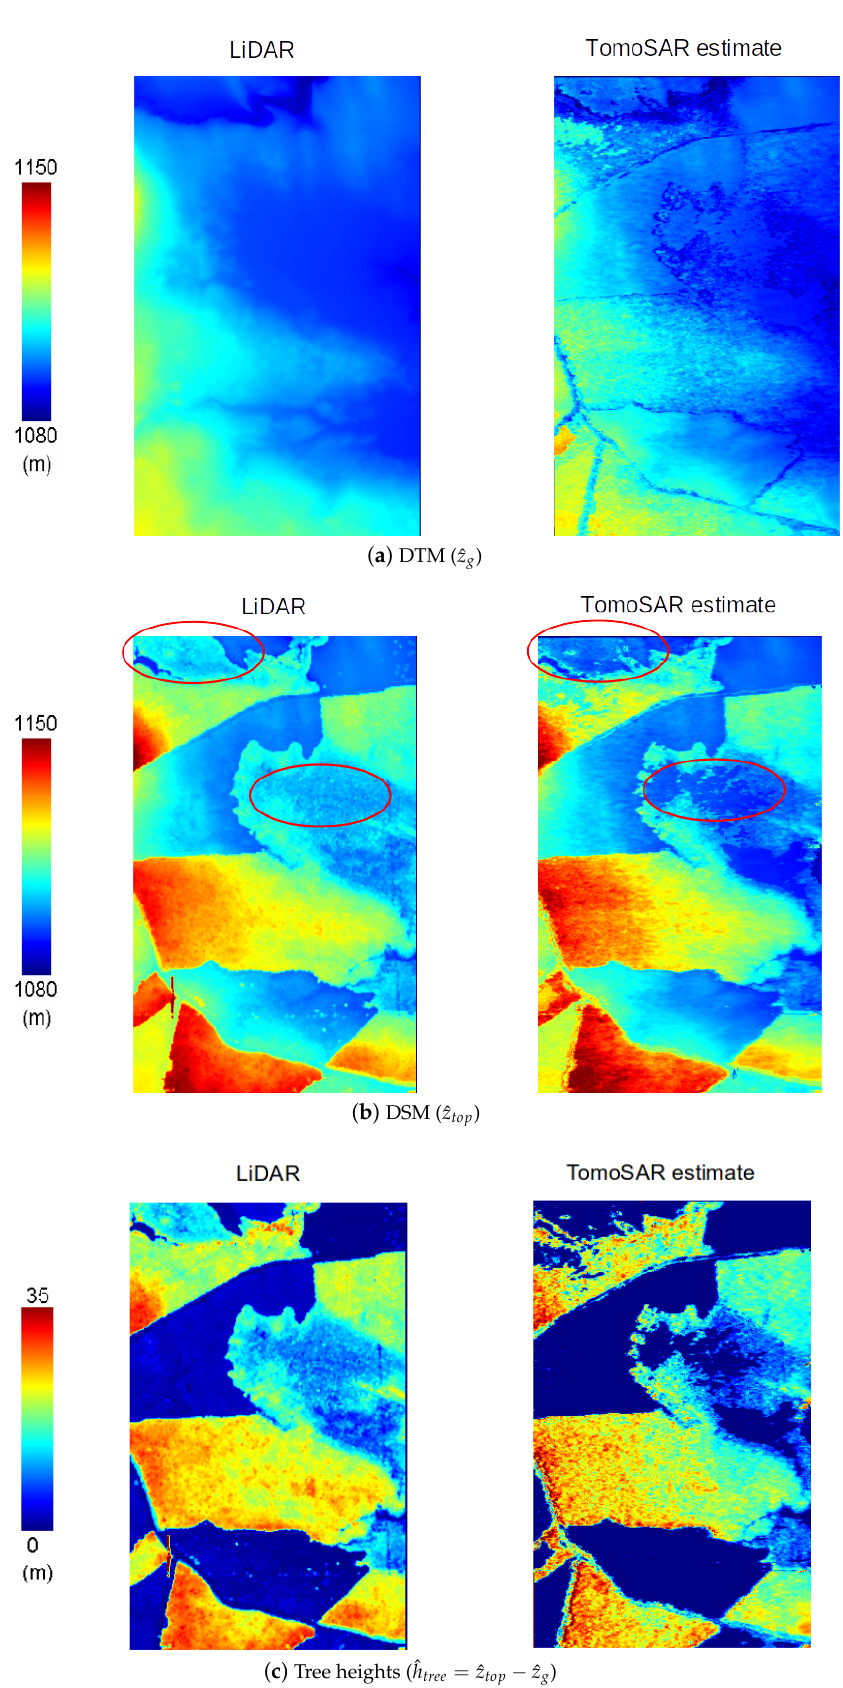
Figure 16. DSM, DTM and tree height maps estimated by the proposed tomographic technique and using LiDAR